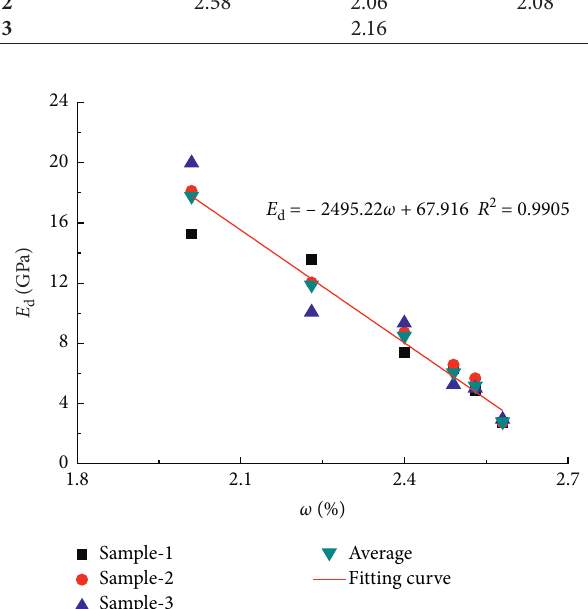
Figure 8: Dynamic elastic modulus variation with moisture content.